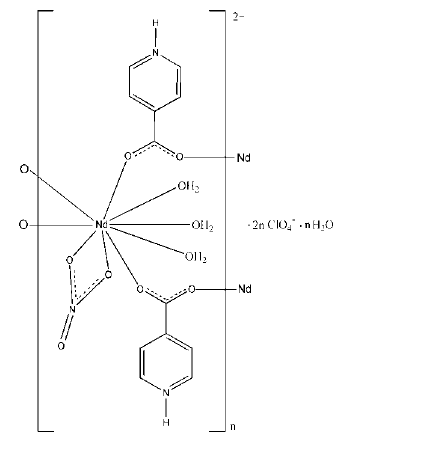
In the title compound, {[Nd(NO (cid:1) H ) O} , the Nd III atom is nine-coordinated by four O (ClO n 4 2 2 atoms from four pyridinium-4-carboxylate ligands, two O atoms from a chelating nitrate anion and three water molecules in a distorted tricapped trigonal–prismatic coordi- nation geometry. Adjacent Nd atoms are linked by the bidentate pyridinium-4-carboxylate ligands into a chain running along the b axis. The chains are further connected by O—H (cid:1) (cid:1) (cid:1) O and N—H (cid:1) (cid:1) (cid:1) O hydrogen bonds into a three- dimensional network. Related literature For related structures, see: Liao et al. (2004); Wang et al. (2004).